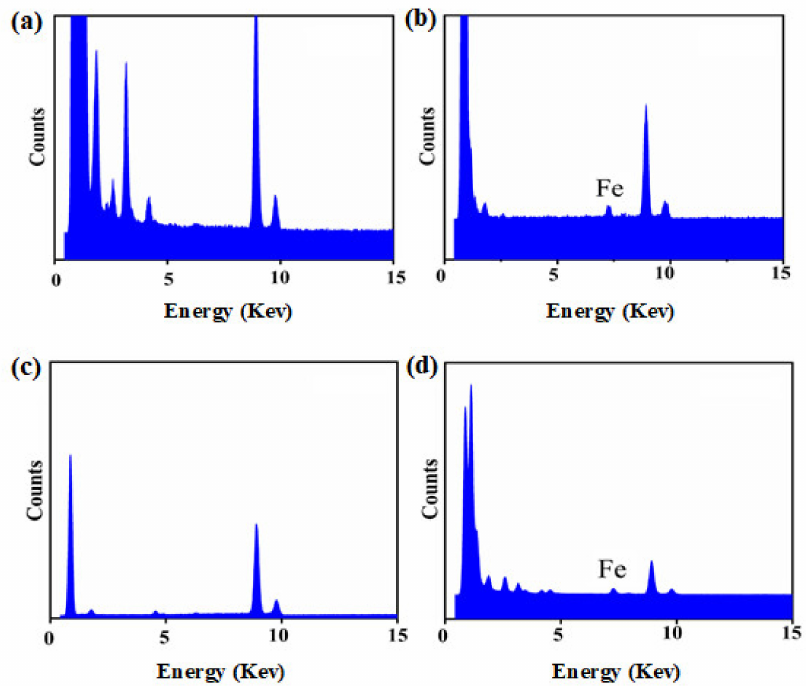
Figure 2. The EDS spectrums of ( a ) Az-WDG, ( b ) Az-WDG-TA, ( c ) Av-WDG, and ( d ) Av-WDG-TA.